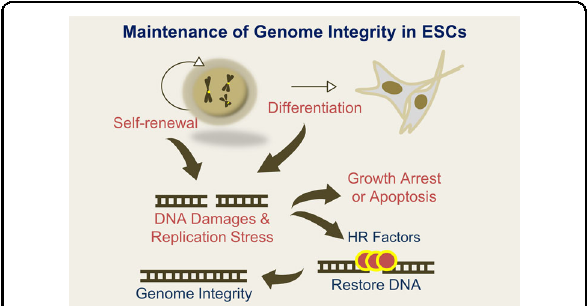
Fig. 4 Maintenance of genome integrity in ESCs. During the self- renewal or differentiation of ESCs, abundant HR factors promote the repair of DNA damage and recovery from replication stress, thereby maintaining genome